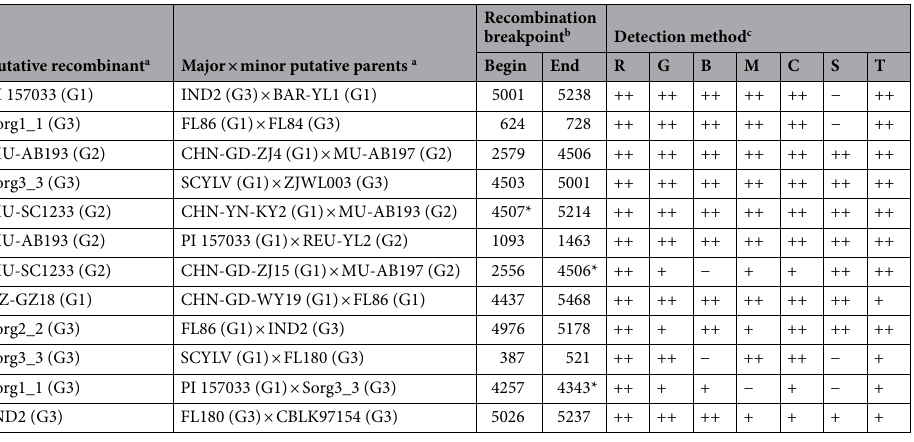
Table 1. Recombination events among 50 sugarcane yellow leaf virus (SCYLV) isolates using RDP4 software. a Phylogroups are shown in brackets. b Actual breakpoint position undetermined (it was most likely overprinted by a subsequent one) shown as an asterisk (*). c Seven algorithms implemented in RDP4 software were used, including RDP (R), GENECONV (G), BootScan (B), Maximum Chisquare (M), Chimaera (C), Sister Scan (S), and 3Seq (T). Symbols are showed for recombination signals at different statistical significance levels: ++, P ≤ 10 –6 ; +, 10 –6 < P ≤ 0.05; −, P > 0.05 (not